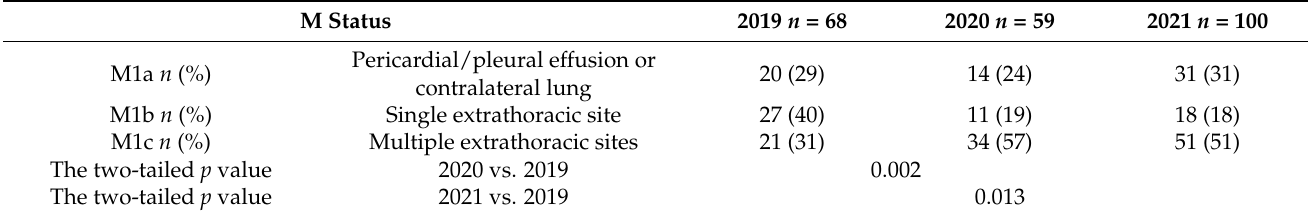
Table 4. Number of distant